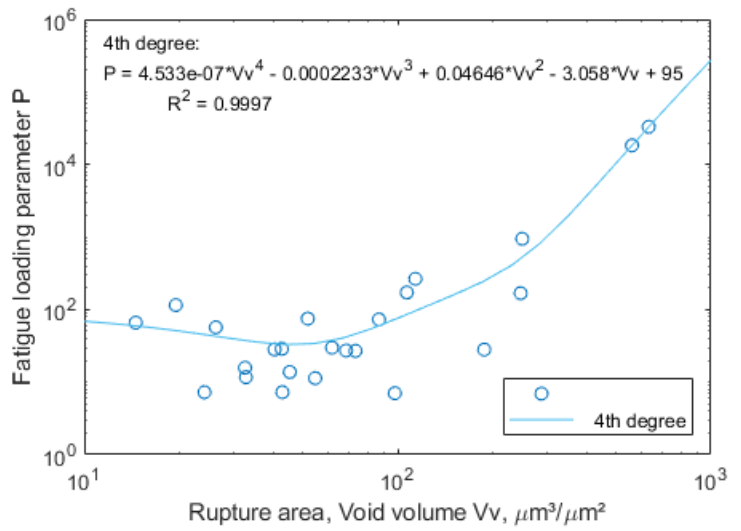
Figure 14. Fatigue loading parameter P vs. void volume Vv in the rupture area and their 4th degree fit. degree